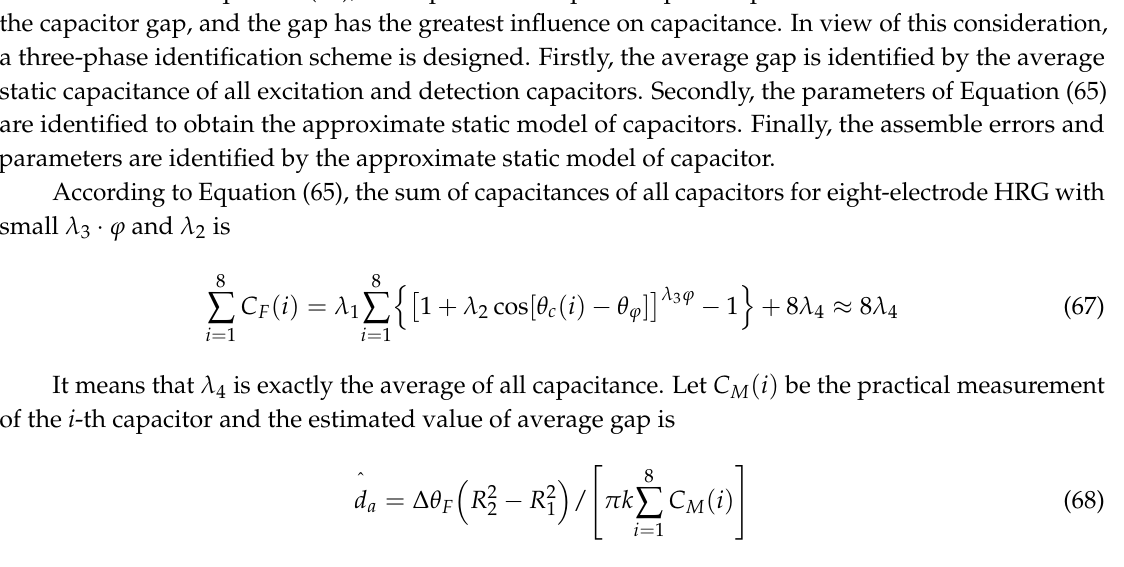
capacitor 1; and, ( c ) Relative error of capacitor 1 when inclination angle is 0 ″ , 10 ″ , 20 ″ , and 30 ″ .